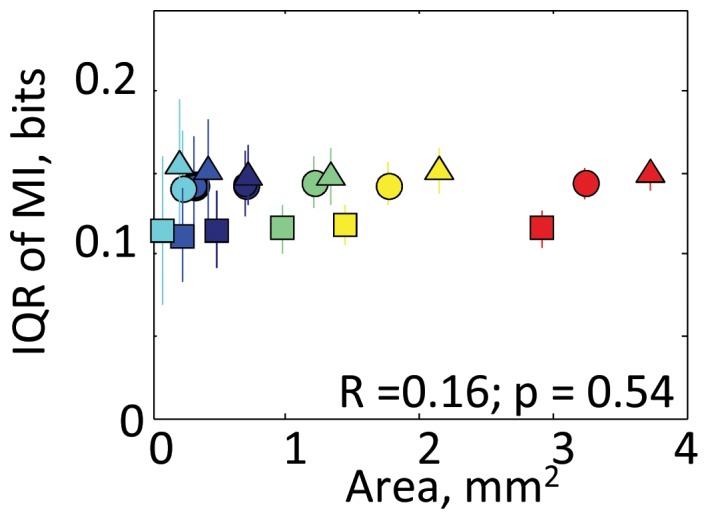
Validation that the positive correlation between the representational area and MI variance is caused by frequency-dependent MI distribution, but not by inadequate sampling.IQR was estimated as a function of the representational area in shuffled data, which were randomly resampled irrespective of any properties. The shapes of symbols indicate the test training groups: circle, naïve; triangle, day 4; and square, day 20. Representational areas of each resampled dataset were determined on the basis of the tonotopic map in each training group. Means and standard deviations are shown when the resampling was conducted 100 times. No significant correlation between IQR and representational area was observed, thereby denying the possibility that IQR may increase with the number of samples because test datasets are inadequately small.